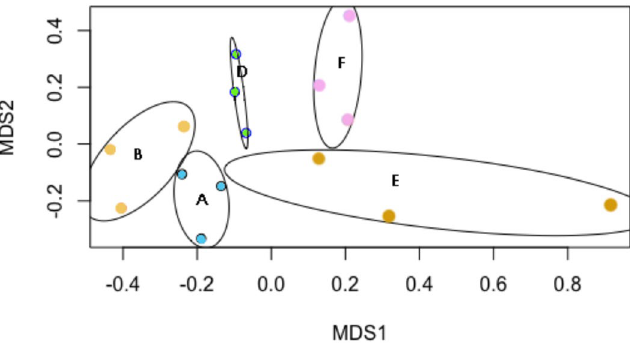
Figure 5. Non-metric multidimensional scaling (NMDS) ordinations based on Bray–Curtis similarities of OTU-based fungal community structures found in P. sylvestris seed samples (A = 100, B = 200; D = 600, E = 800; F = 1000 seeds) (Stress value =